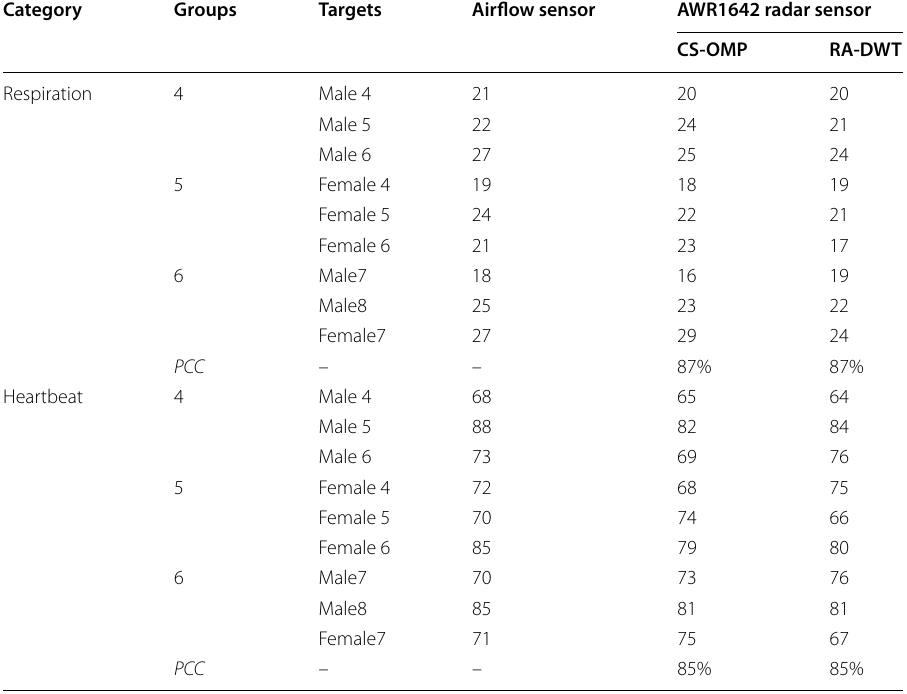
Table 3 Comparison of the respiration and heartbeat rates between three targets Category